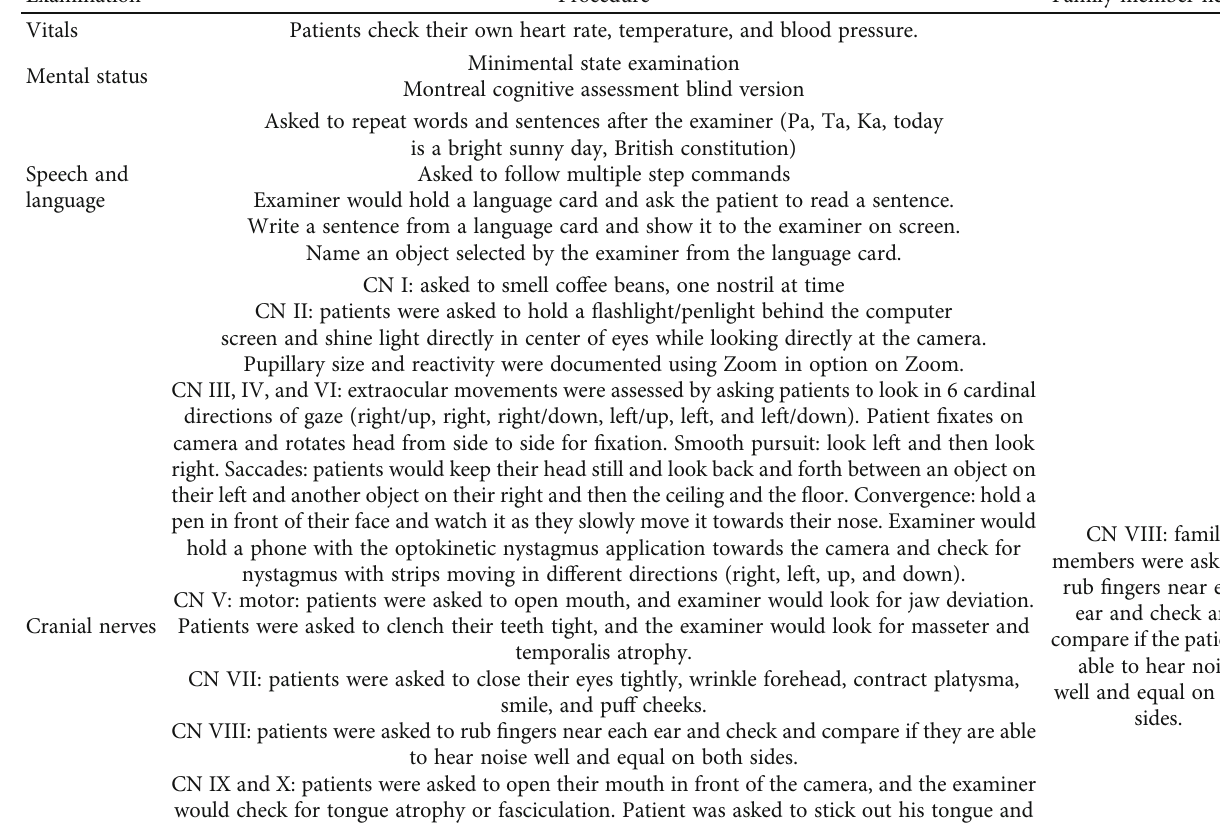
Table 1: Detailed neurological examination performed during telehealth